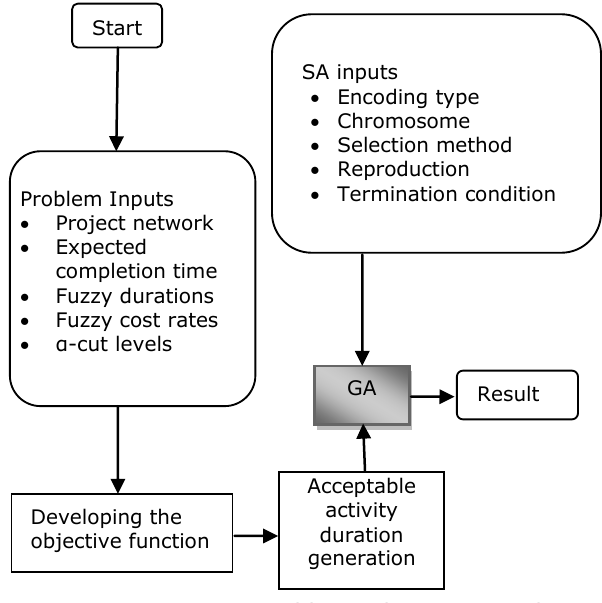
Figure 5. GA problem solving approach